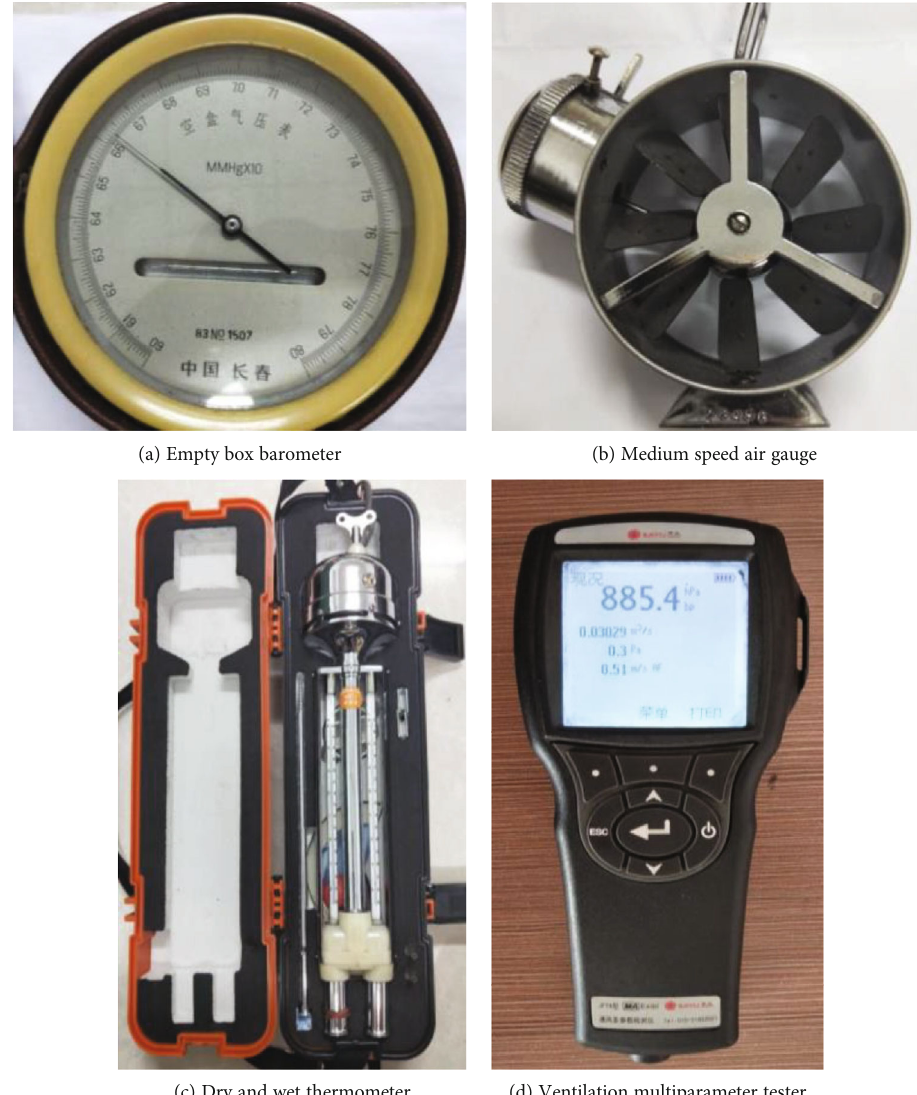
Figure 10: Air pressure observation